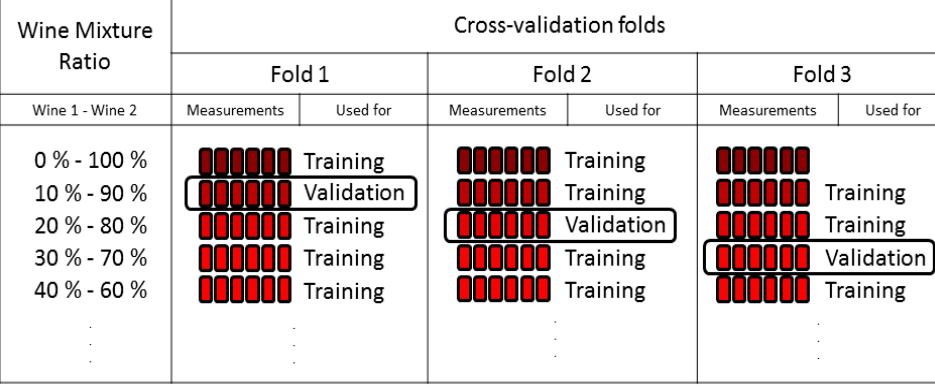
Figure 2. Validation scheme. In each fold of the cross validation all the measurements corresponding to one ration mixture are used for the validation and the rest is used in the training, the wines without mixtures are used only for